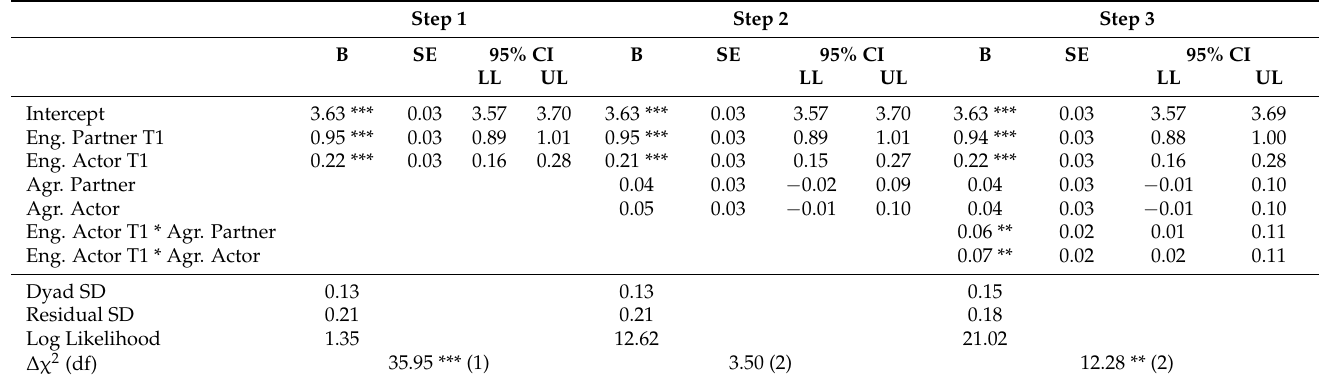
Table 2. Effects of agreeableness and actor’s engagement on partner’s engagement.